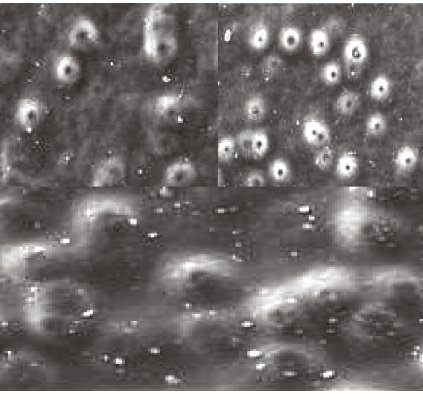
Figure 1: Smoothness. Table 1: Properties of polymers at different concentrations. Concentration Conductivity Viscosity Surface